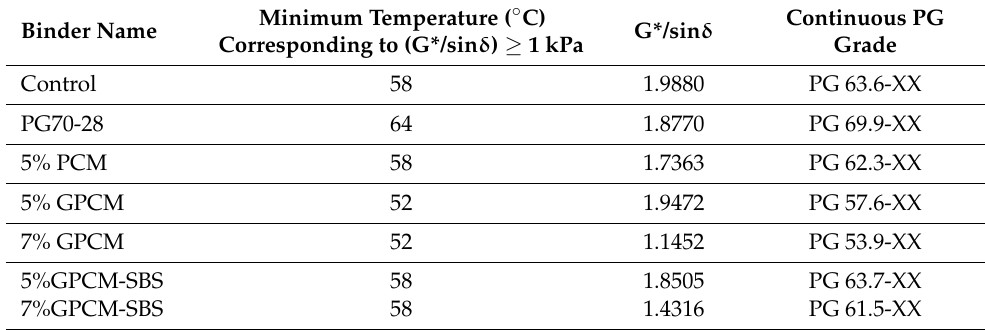
Table 7. Minimum temperature corresponding to (G*/sin δ ) ≥ 1 kPa and G*/sin δ